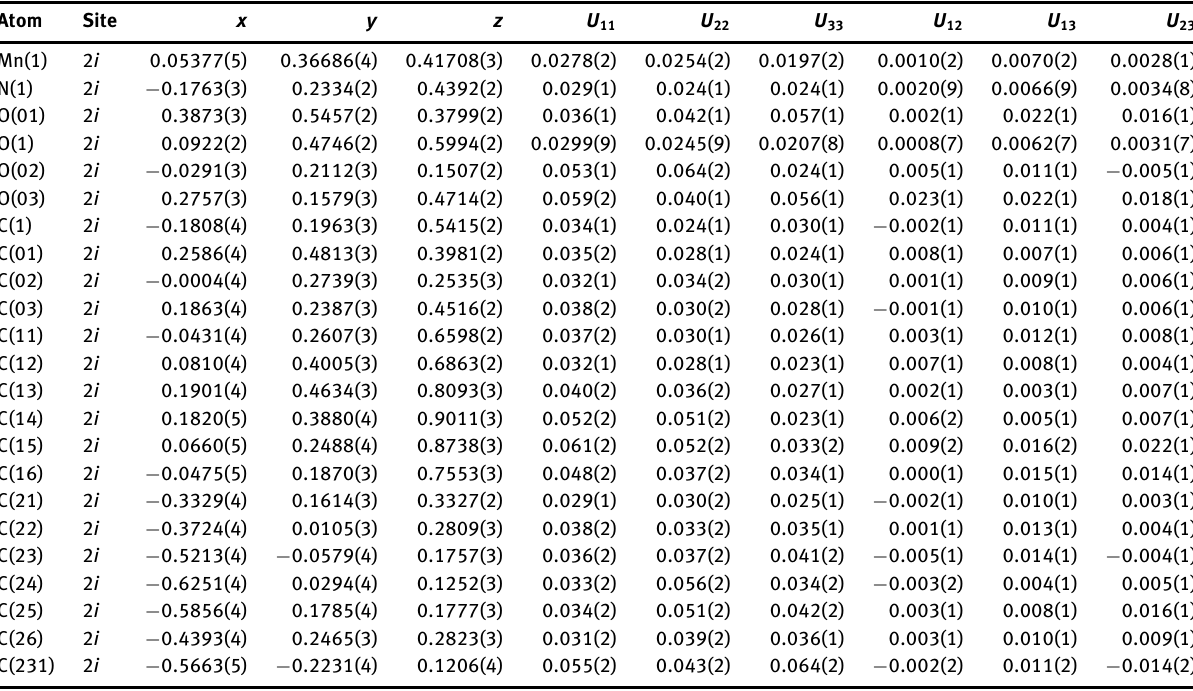
Table 3: Fractional atomic coordinate and displacement parameters (Å 2